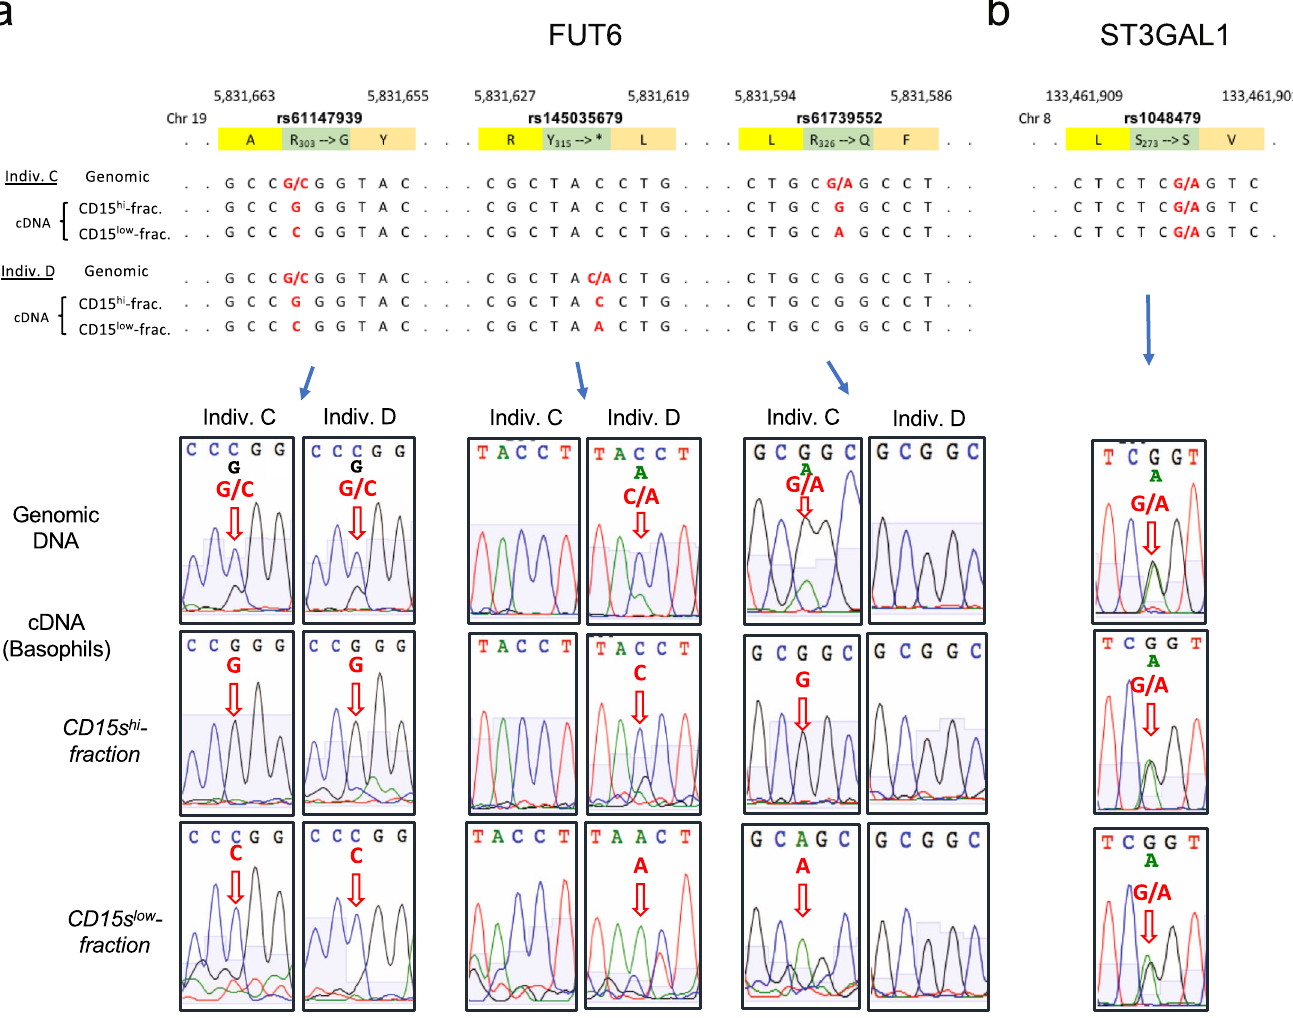
Fig. 6 Random monoallelic expression of FUT6. a FUT6 transcripts in basophils from the CD15s high and CD15s low fraction. cDNAs from the CD15s high and CD15s low basophil fraction of two CD15s bimodal individuals were isolated, and the region encoding for FUT6 ampli fi ed by PCR and sequenced. The upper panel displays the FUT6 sequence of the genomic DNA and the two cDNA regions covering three coding SNPs (rs61147939, rs145035679, and rs61739552). Each of the donors was heterozygous for two of these SNPs. Polymorphic bases are highlighted in red; base pair position as well as encoded amino acid residues are indicated. The histograms of the sequencing are displayed in the lower panels. Signals derived from polymorphic sites are indicated by red arrows. b ST3GAL1 transcripts. As a control, cDNA sequencing of ST3GAL1 , a gene not known to be controlled by random monoallelic expression, is shown. The donor was heterozygous for rs1048479. Only the sequence proximal to this SNP is